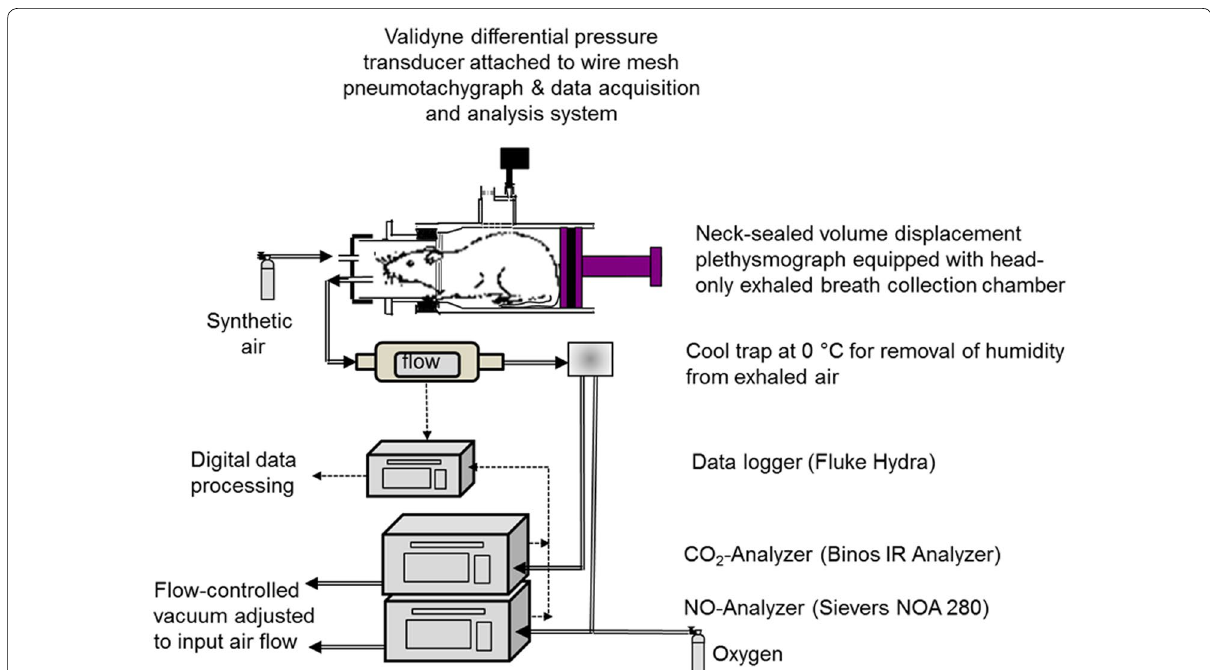
Fig. 5 Schematic of the experimental arrangement to measure eNO, eCO 2 and breathing frequency in spontaneously breathing, conscious rats. Rats were placed into a two-compartment restraining tube for data collection periods of 10 min (thoracic compartment: volume displacement plethysmograph; head-out compartment: bias-flow of synthetic air with manifold to the NO-chemiluminescence and infrared CO 2 -gas analyz- ers connected to a mass-flow controlled vacuum). ‘Flow’: mass flow meter/controllers. Dotted lines electrical connections, double lines: ducts for analyses in expired